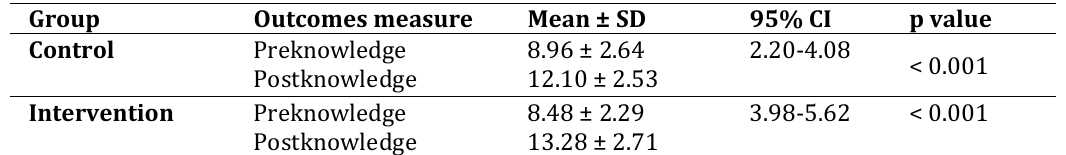
Pre- and Post-Diabetes knowledge using paired t-test Group